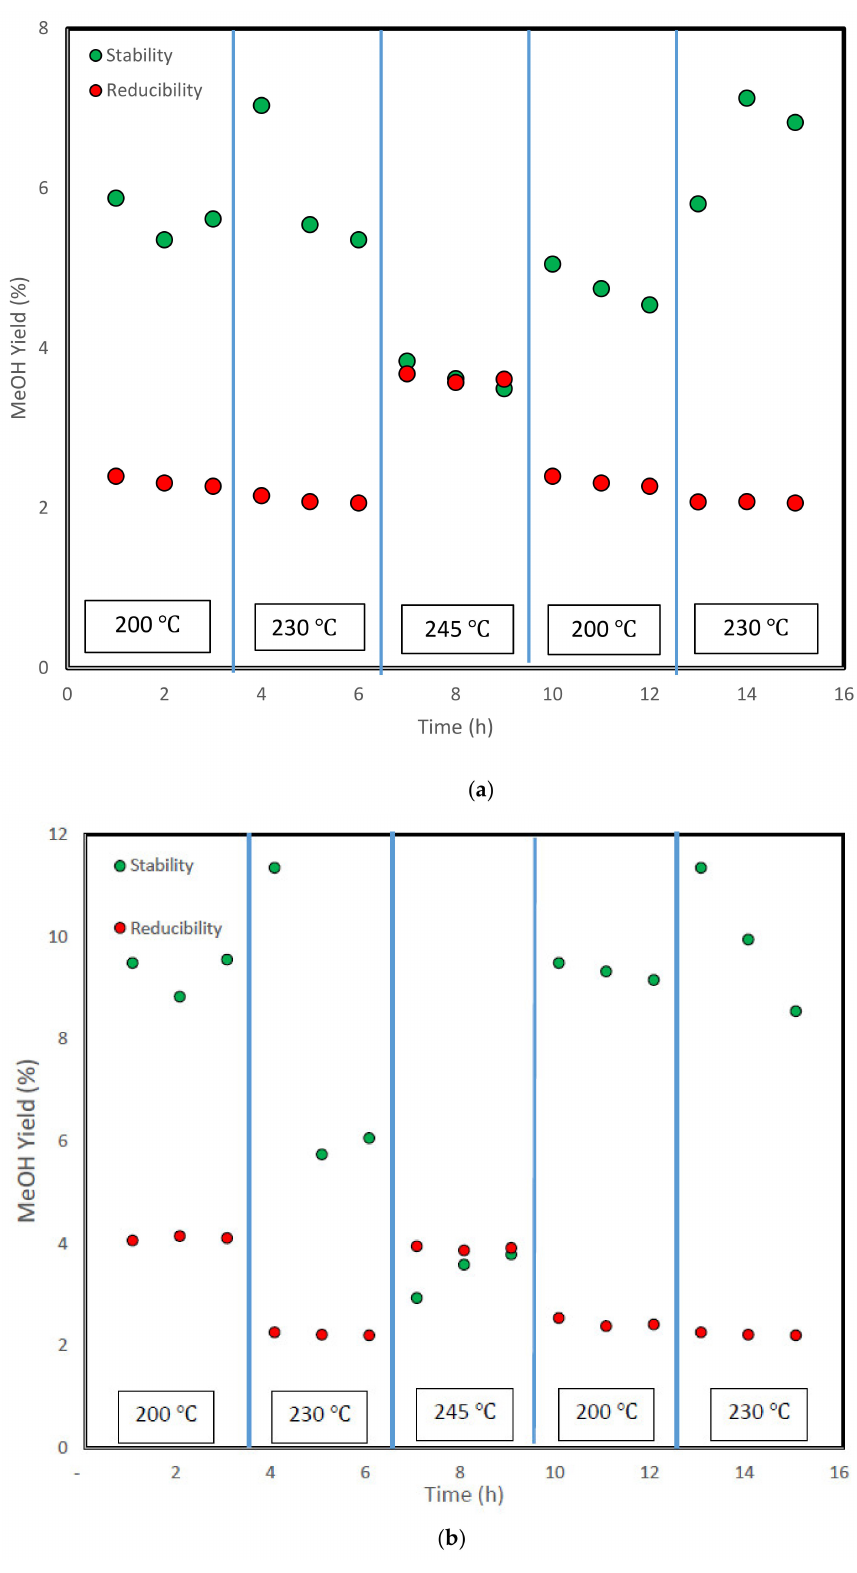
Figure 4. Stability and reducibility of ( a ) MET1, ( b ) MET2; reaction condition: H 2 / CO 2 = 3, T = 200–245 ◦ C, P = 9 bar g, GHSV = 200 h − 1